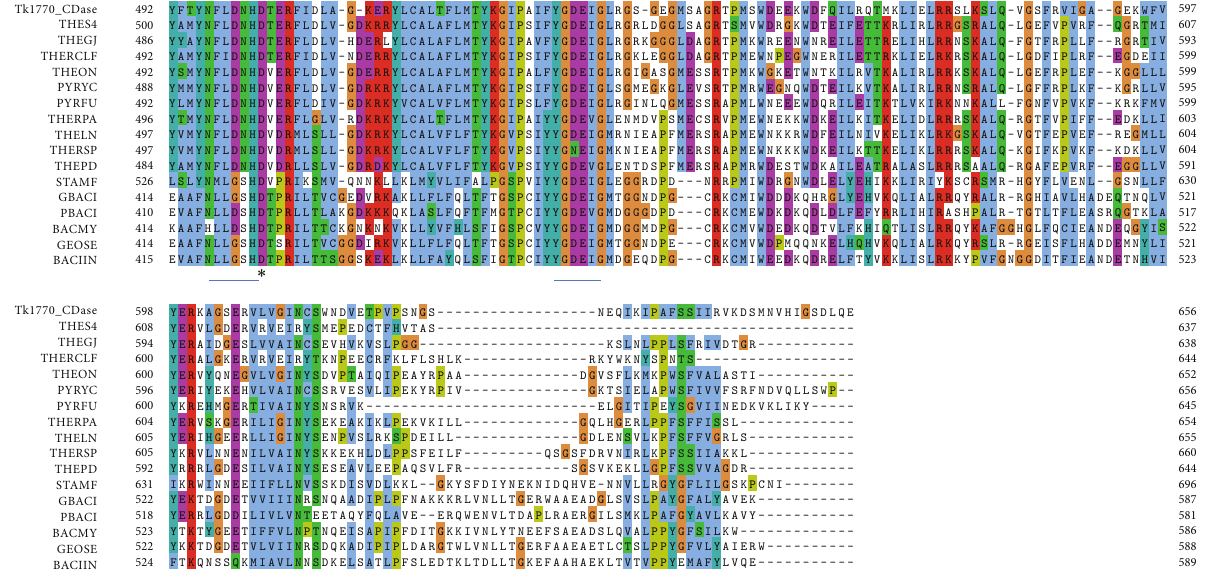
Figure 1: Sequence alignment of Tk1770 CDase with sixteen CD hydrolyzing enzymes. The alignment of Tk1770 CDase with archeal and bacterial CD hydrolyzing enzymes was carried out with Clustal Omega through UGENE package. The novel N 󸀠 -domain (CBM48) in archeal sequences is represented in red and the protruding region of CBM48 domain in green dotted line. The arrow shows the start of the TIM barrel domain (residues 204–584) and four conserved regions (I–IV) with another downstream conserved region V are represented in grey line below sequence. The catalytic triad is indicated through esterics. The HLH region of archeal sequences that is absent in all bacterial homologs is represented in blue dotted line.